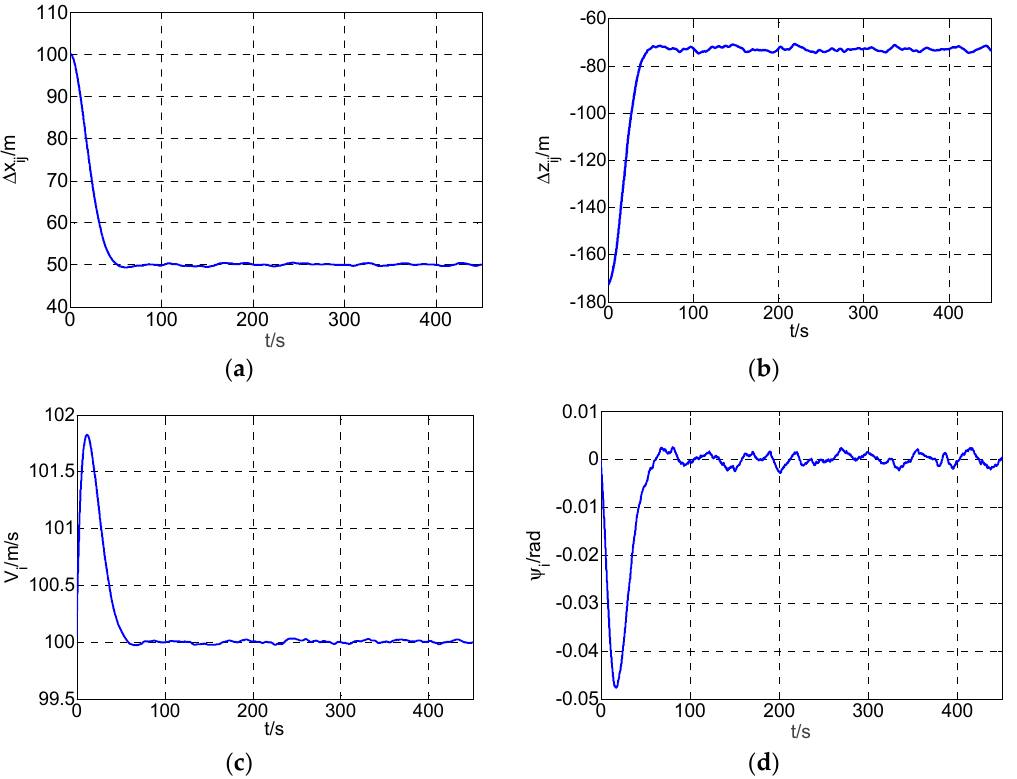
Figure 6. Simulation results of node ν i. ( a ) forward distance; ( b ) lateral distance; ( c ) speed; ( d ) flight path declination.